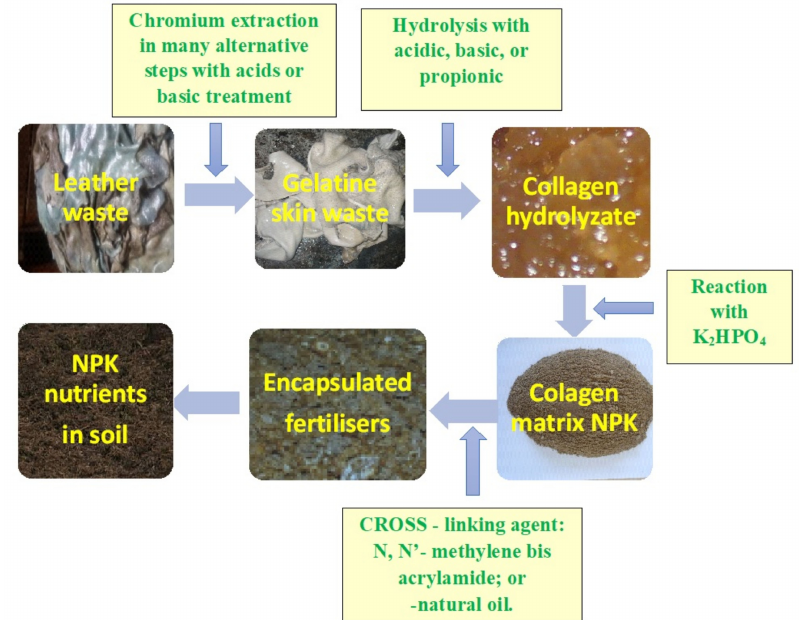
Figure 6. From waste leather to bio-polymer fertilizer—Intermediary products [87].